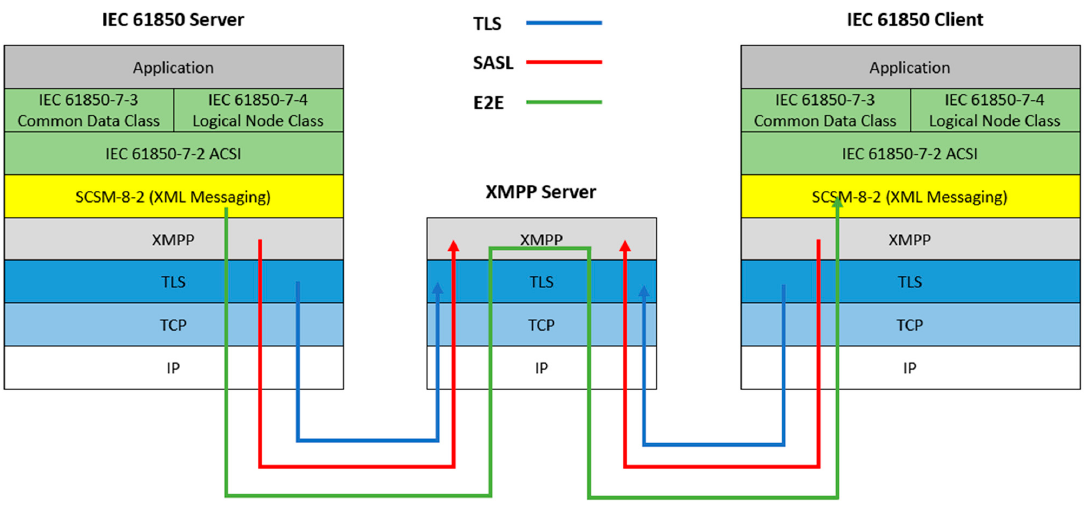
Figure 5. XMPP security options.